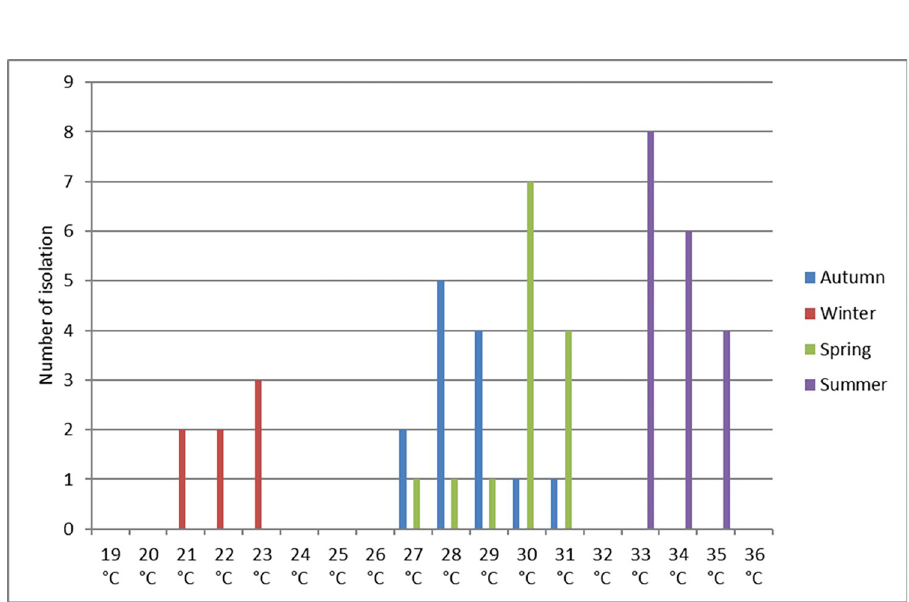
Fig 3. Correlation between the frequency of FLA and water temperature at the sampling time.